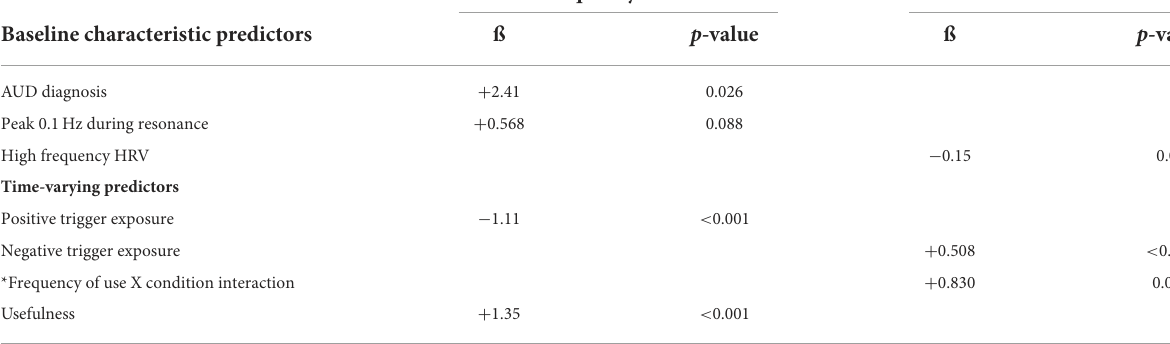
TABLE 3 Standardized beta weights of significant predictors.